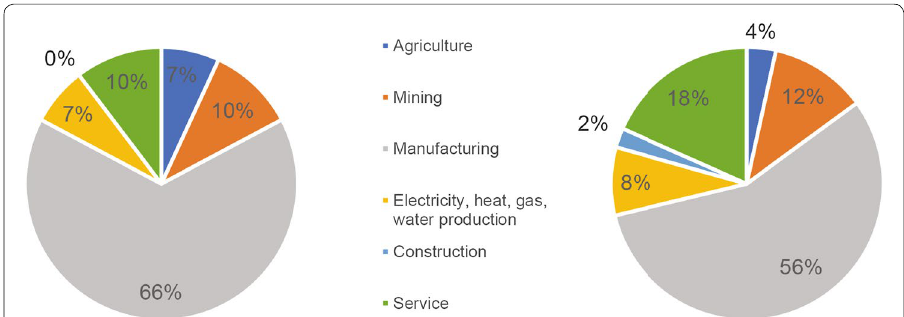
Fig. 1 Sector distributions of key coefficients, viewed by row (left) and column